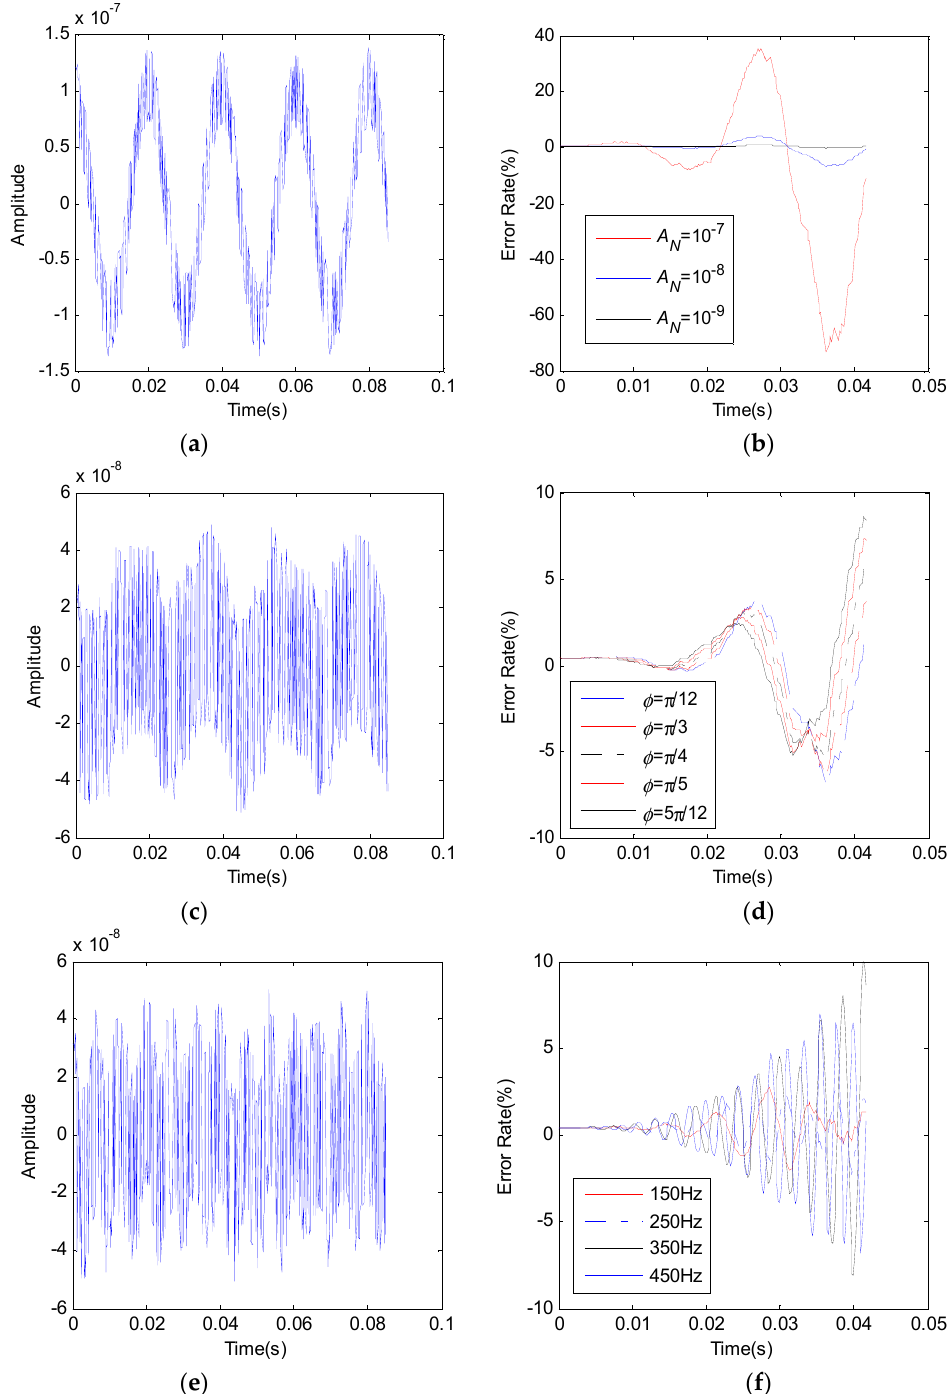
Figure 10. Suppression of sinusoidal noise by m-sequence. ( a ) Superposition of excitation field and noise signal 10 − 7 cos ( 2 π × 50 t ) ; ( b ) identification error of different amplitude noise; ( c ) superposition of excitation field and noise signal 10 − 8 cos ( 2 π × 50 t + 5 π /12 ) ; ( d ) identification error of different phase noise; ( e ) superposition of excitation field and noise signal 10 − 8 cos ( 2 π × 150 t ) ; ( f ) identification error of different frequency noise.